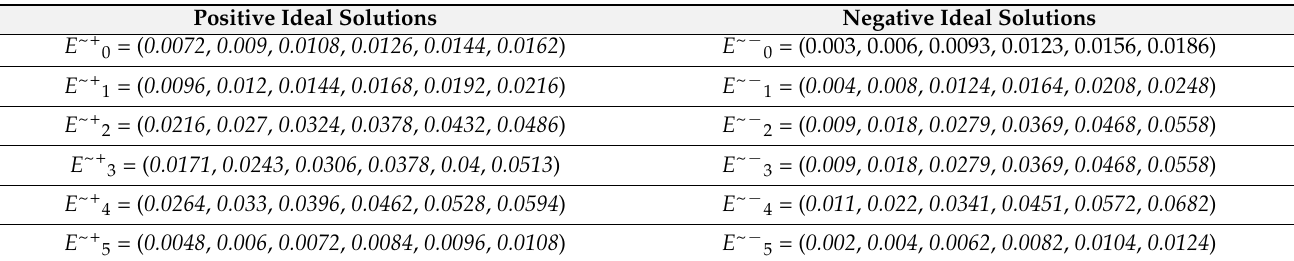
Table 11. The positive and negative ideal solution.